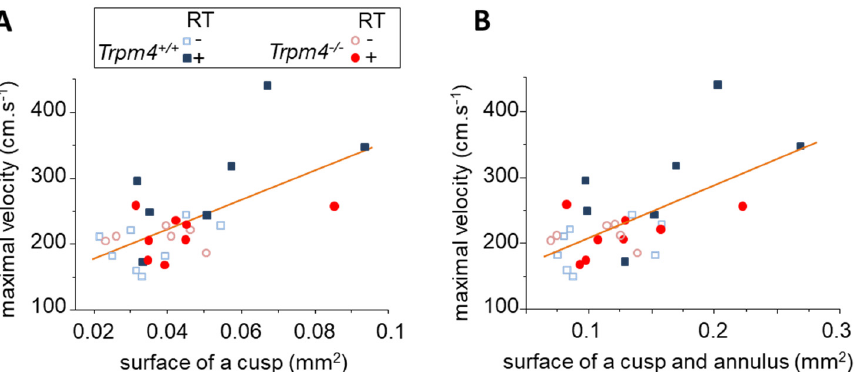
Figure 4. Morphological and functional remodeling relationship. For each mouse, the surface of an aortic valve cusp ( A ) as well as the surface of a cusp and annulus ( B ) were plotted to the maximal aortic valve jet velocity measured at 5 months post-treatment. Each group is represented by a different symbol as indicated in the legend. Altogether, the data were plotted to a linear regression indicating a significant relation between parameters. Pearson’s r was 0.61 for velocity/cusp and 0.62 for velocity/cusp + annulus.